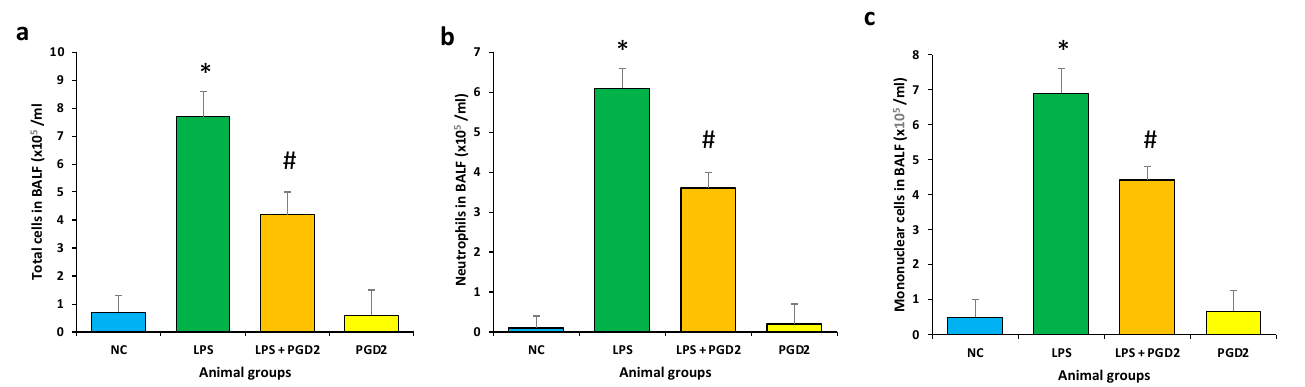
Figure 5. Effects of LPS challenge on total cell, neutrophil, and mononuclear cell counts in LPS- exposed (5 mg/kg b.w.) and PGD 2 (100 µ g/kg b.w.)-treated mice. The figure ( a ) represents total cells; ( b ) Neutrophils; and ( c ) Mononuclear cells in different treatment groups The significant changes ( p < 0.05) are represented by (*) between the control group and LPS groups and (#) between the control group and LPS + PGD 2 groups.